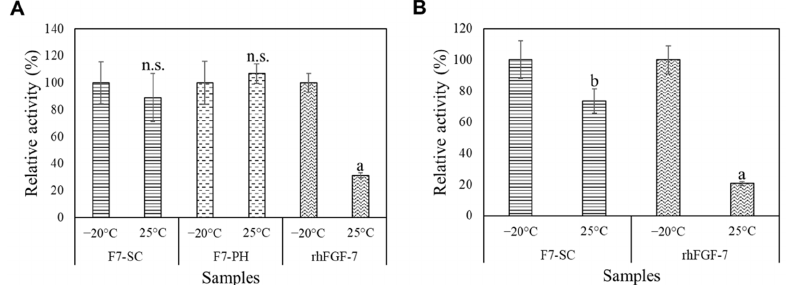
Figure 6. Storage stability of H1/FGF-7 incorporated into sericin-cocoon powder. ( A ) Short-term (7 days) storage stability. Two identical sets of samples including suspensions of F7-SC powder (2 mg/mL), F7-PH crystals (1 × 10 7 cubes/mL), and a solution of commercial rhFGF-7 (50 µ g/mL) were separately stored at − 20 ◦ C or 25 ◦ C for 1 week prior to the assays. NHEK cells at a density of 7500 cells per 500 µ L of DK-SFM were supplemented with 100 µ g of F7-SC powder, 5 × 10 5 F7-PH crystals, or 10 ng of rhFGF-7. Proliferative activity of the samples was determined as viable cell number measured in the respective cultures after 3 days of cultivation at 37 ◦ C and 5% CO 2 . The proliferative activity of the samples stored at − 20 ◦ C was set to 100%, and the relative activity of the corresponding samples stored at 25 ◦ C was determined. ( B ) Long-term (3 months) storage stability of H1/FGF-7. The parameters and analysis method were the same as the 1-week analysis except for sample storage duration. Data are shown as means ± standard deviations (SDs) of triplicate assays. n.s p > 0.05 vs. − 20 ◦ C counterpart; a p < 0.001 vs. − 20 ◦ C counterpart; and b p < 0.01 vs. − 20 ◦ C